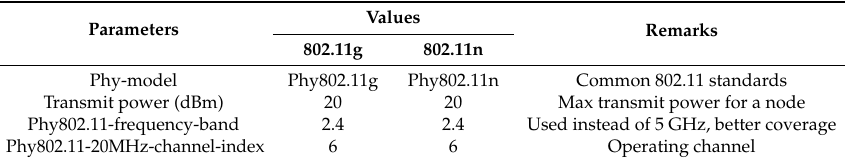
Table 4. IEEE 802.11g/n physical configuration parameters.